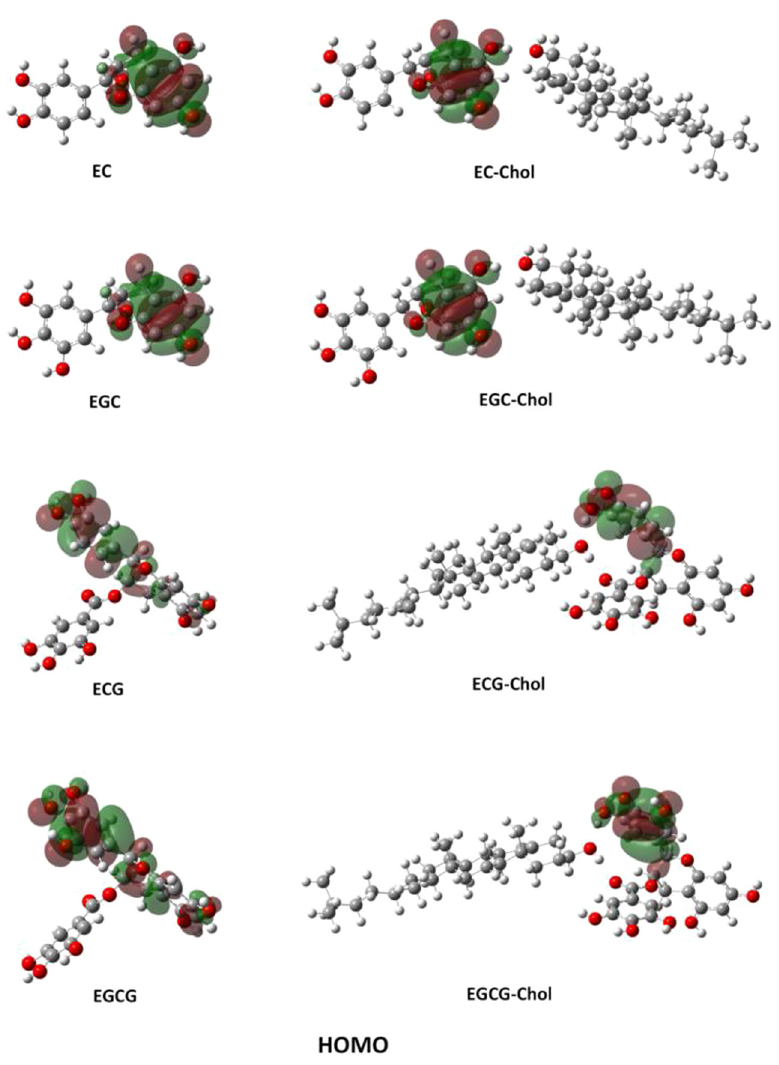
Figure 6: HOMO of EC, EGC, ECG, EGCG and catechin complexes at the level of B3LYP/6 - 31G ( d )